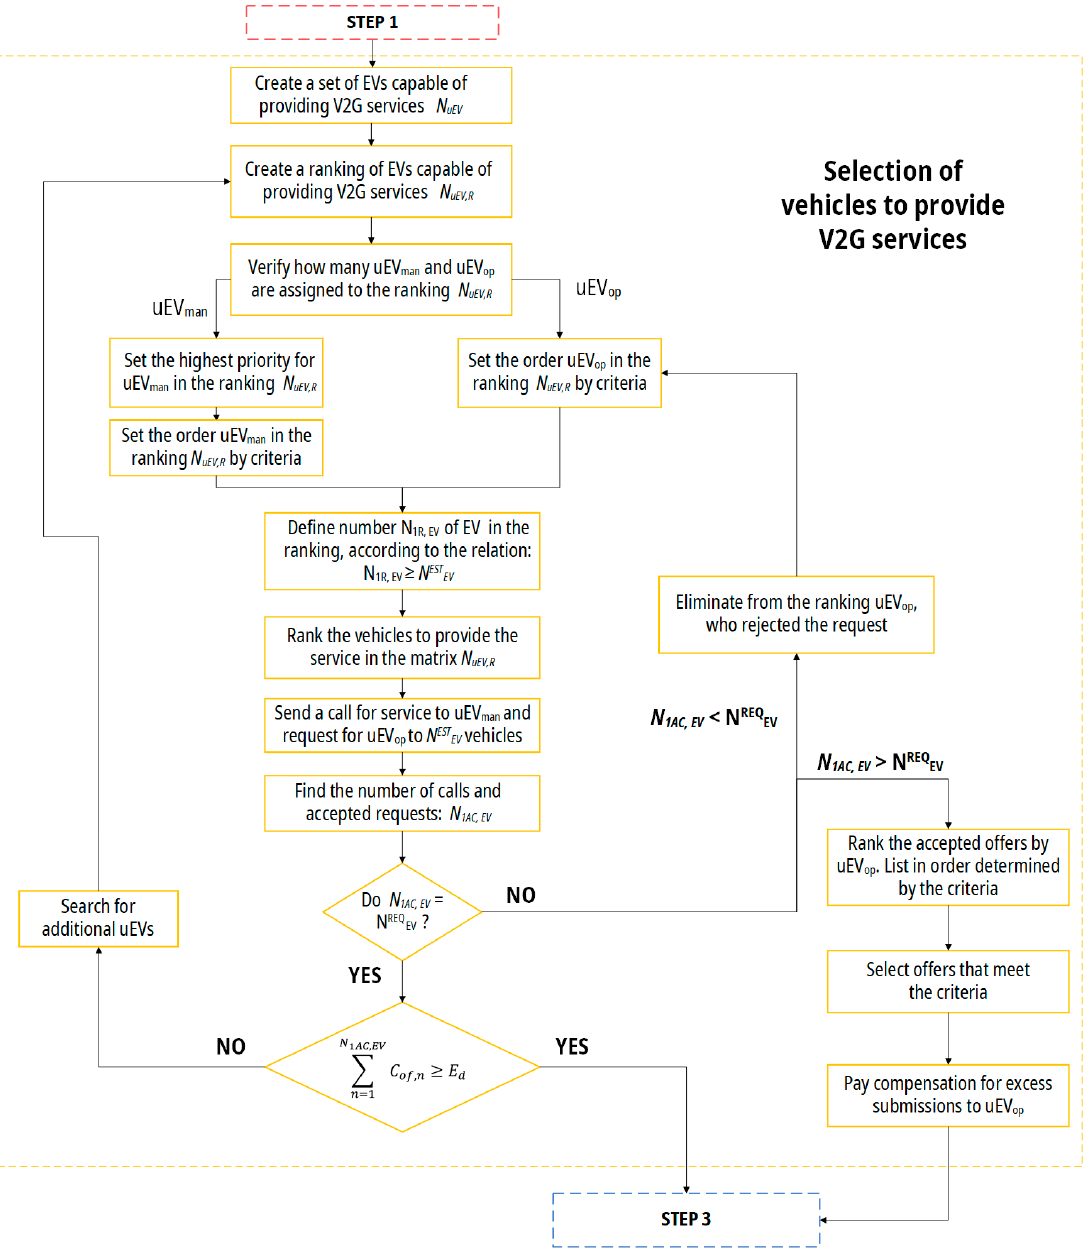
Figure 6. Second part of proposed algorithm—selecting vehicles to provide V2G services.